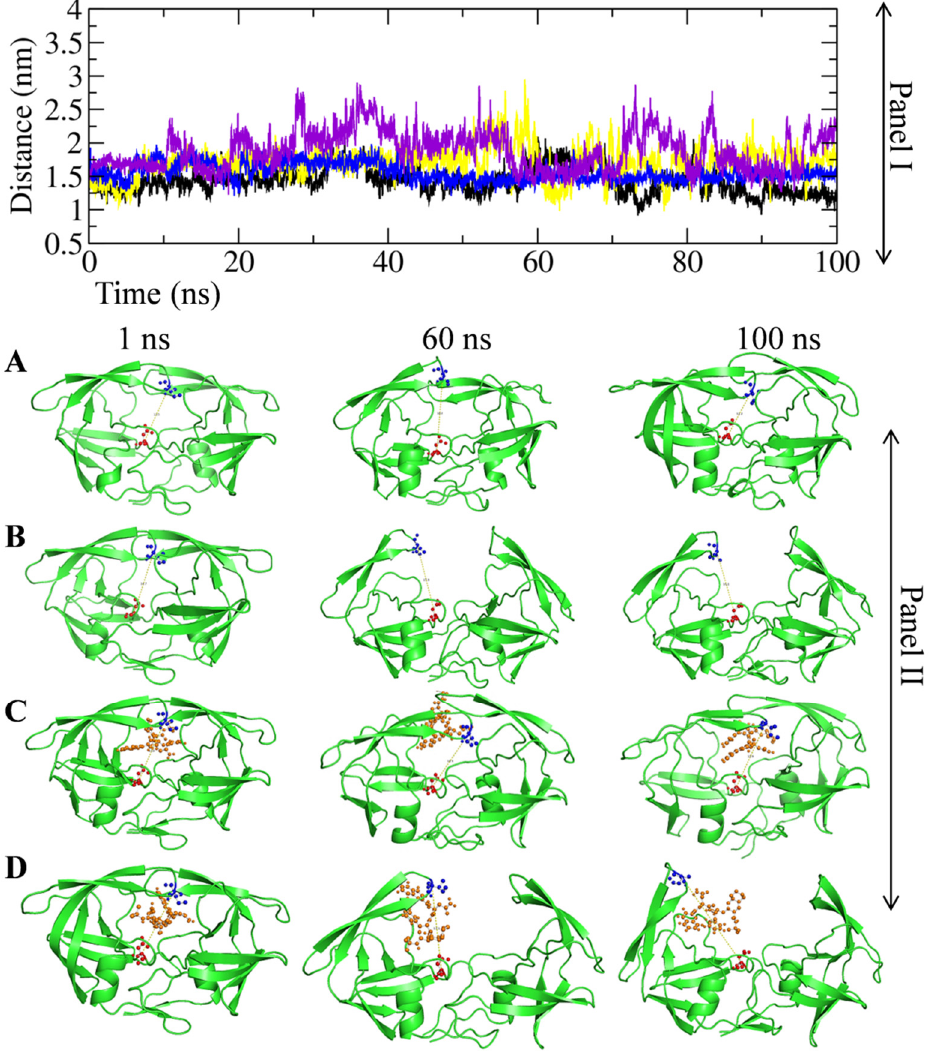
Figure 5. Effect of the M46I mutation on the active site compactness of the saquinavir-bound HIV-1 protease. Panel I shows the change in distance between Asp25 and Asp124 in the WT, SQ-WT, MI, and SQ-MI systems during the 100 ns simulation. The black, blue, yellow, and purple colors represent the WT, SQ-WT, MI, and SQ-MI systems. WT, Wild-type; SQ-WT, Saquinavir-bound wild-type; MI, M46I-mutation-carrying protease; and SQ-MI, Saquinavir-bound mutation-carrying protease. Panel II shows the change in the Asp25 and Asp124 distance values in the ( A ) WT, ( B ) SQ-WT, ( C ) MI, and ( D ) SQ-MI systems at different snapshots (1, 60, and 100 ns) of the MD simulation trajectory. The red and blue colors indicate the Asp25 and Asp124 residues, respectively. The HIV-1 protease and saquinavir structure are shown in green and orange colors, respectively.